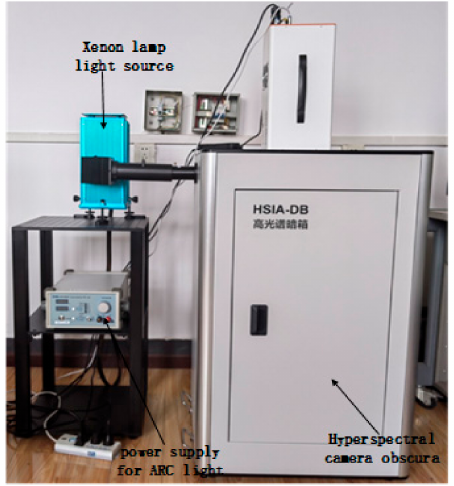
Figure 3. GaiaFluo hyperspectral fluorescence testing